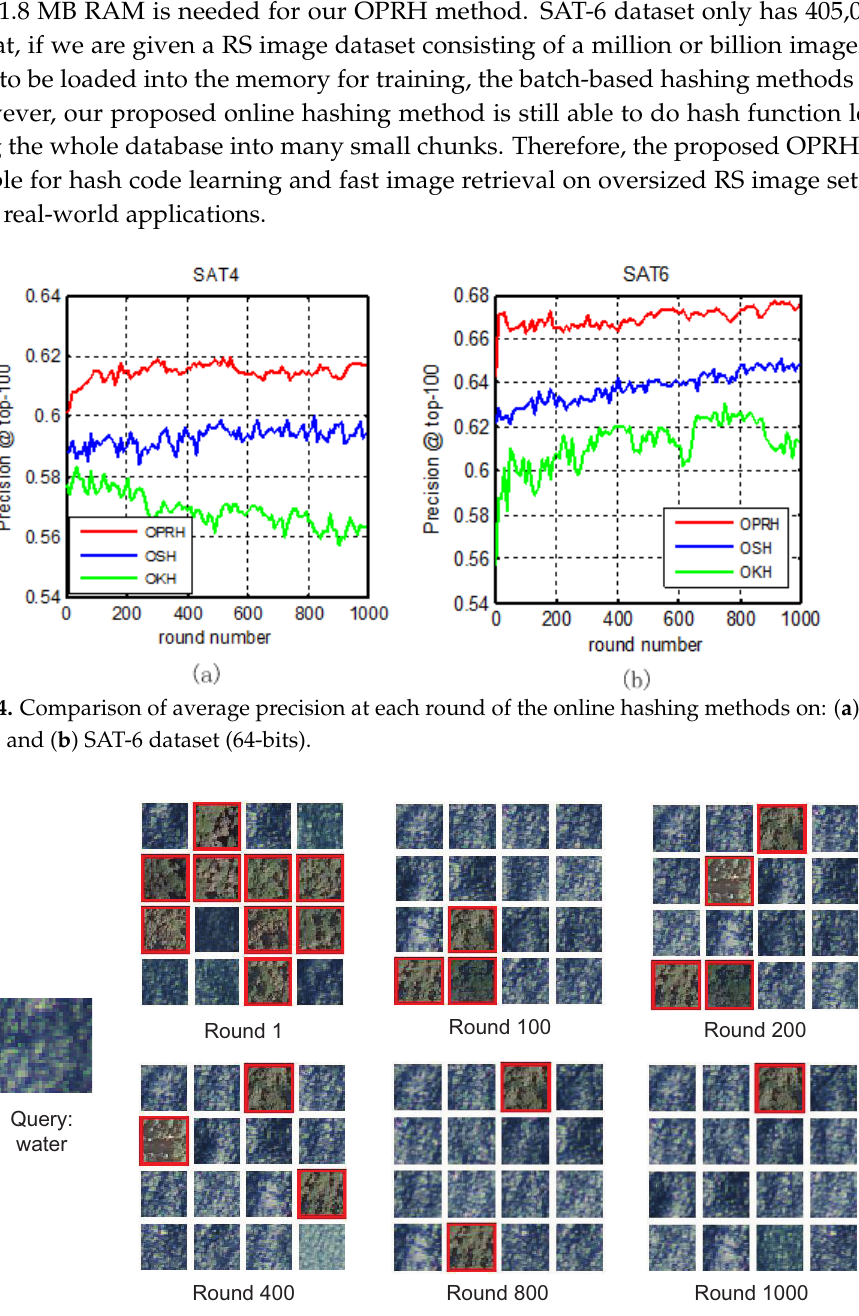
Figure 5. Visualized retrieval example after different rounds by our OPRH method on SAT-6 dataset with 64-bits. Top-16 returned image patches for the query are shown for each round and the false positives are annotated with a red